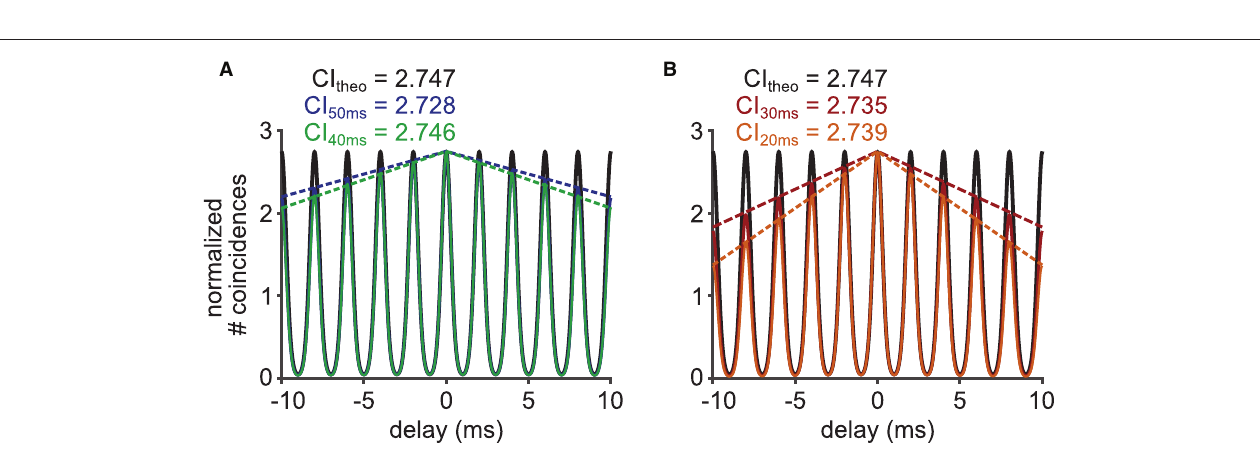
FIGURE 5 | Comparison of empirical and simulated data. (A) ITD-tuning curve of the 700 Hz alligator NL unit used for Figures 4E1–E3 . Error bars represent standard deviations (5 repetitions for each ITD). (B) Phase histograms and (C) SACs of the same NL unit (blue) and simulated spike train (red) that was generated with an inhomogeneous Poisson process whose intensity function is modeled with the empirical phase histogram without any additionally assumed trial-to-trial relations.